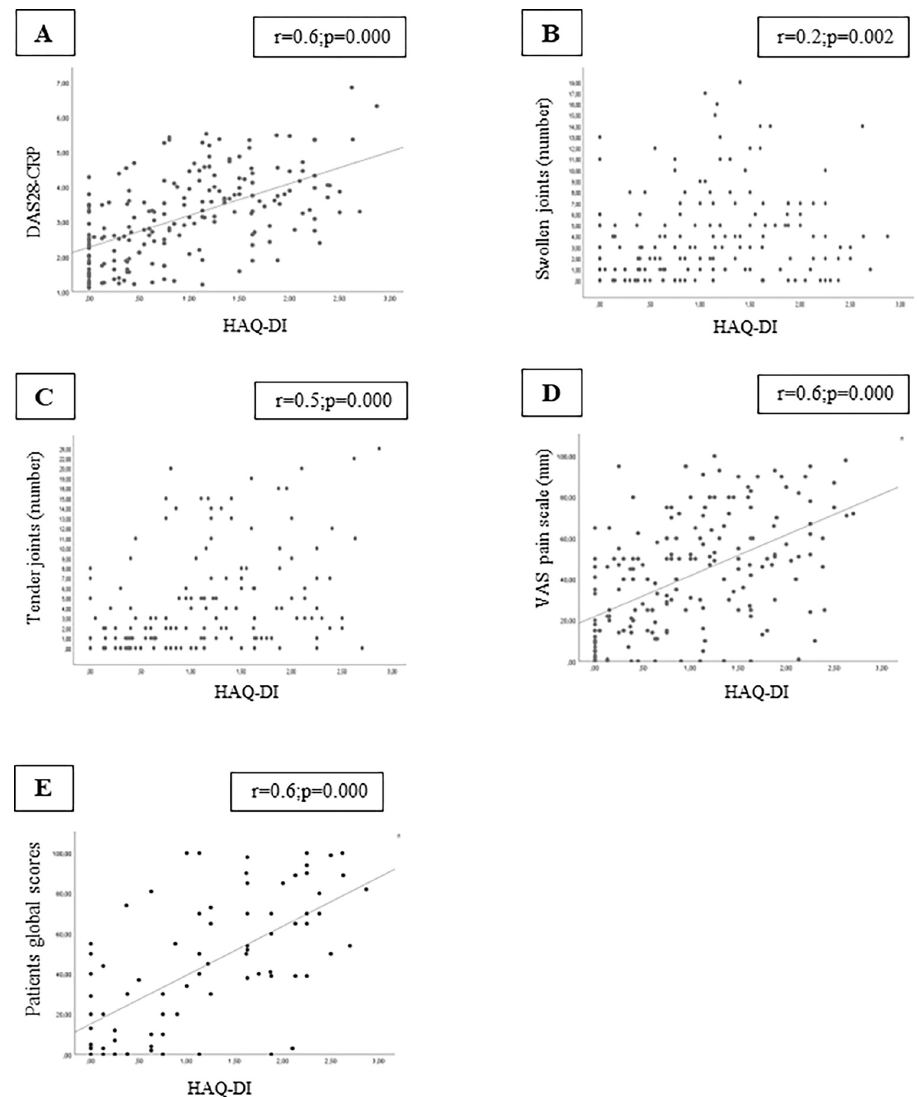
Fig 2. Correlation analysis was significant between HAQ-DI and (A) DAS28-CRP, (B) swollen joints. (C) Tender joints, (D) VAS pain scale, and (E) patients global scores in the Brazilian cohort. Abbreviations: HAQ-DI, Health Assessment Questionnaire-Disability Index; DAS28-CRP, Disease Activity Score in 28 Joints–C-reactive protein; VAS, visual analogue scale.